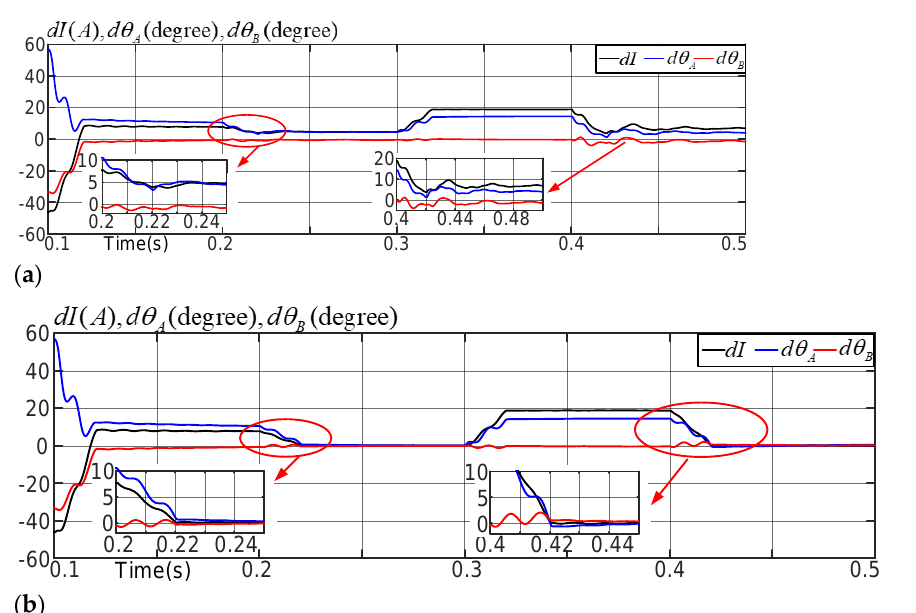
Figure 13. Simulation results dI , dθ A and dθ B of Case 4 and Case 5. ( a ) In Case 4; ( b ) In Case